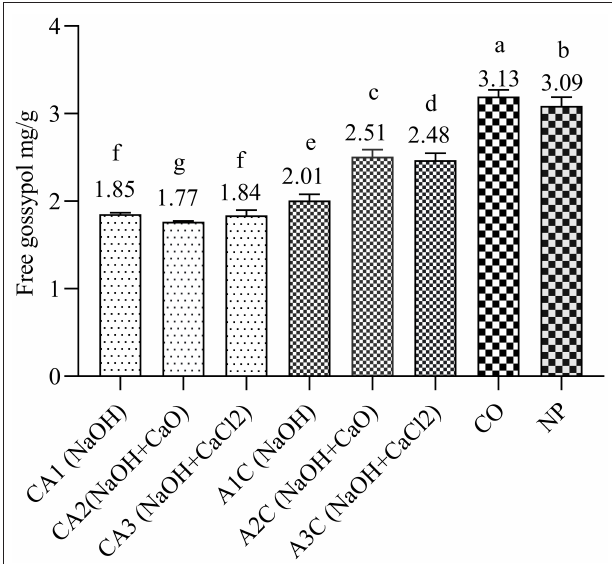
FIGURE 1 | The effect of different processing methods on free gossypol content of WCS. In the column diagram above, values with different small letter superscripts indicate significant difference ( P < 0.05), while with the same letter superscripts indicate no significant difference ( P > 0.05).